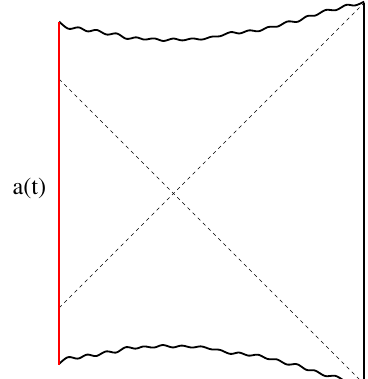
Figure 1 . Penrose diagram for spacetimes associated with certain black hole microstates. The spacetime terminates on the left with an e(cid:11)ective end-of-the-world brane (shown in red on the left) whose worldvolume geometry is a four-dimensional FRW big bang/big crunch cosmology. For certain brane trajectories, the physics of the left region would correspond to a Randall-Sundrum II cosmology, with gravity localized on the brane. If there are CFT states that realize this scenario, the CFT would provide a complete microscopic description of this